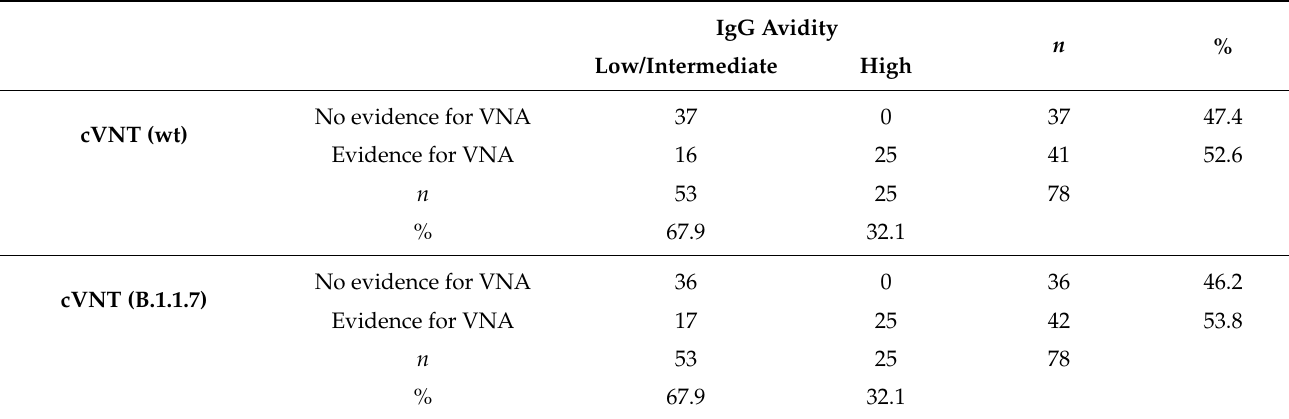
( a ) ( b ) Figure 6. Comparison of the results of the surrogate neutralization tests (sVNT) #1 ( a ) and #2 ( b ) with those of the cell-based neutralization test (cVNT) using a ‘wildtype’ SARS-CoV-2 strain (wt) and a B.1.1.7 strain as antigens. A serum dilution of >1:10 is considered as protective. The decision limits for relevant inhibition of SARS-CoV-2 receptor-binding domain interaction with the human angiotensin-converting enzyme 2 varies between ≥20% (sVNT#2) and ≥30% (sVNT#1). Spearman correlation coefficients were calculated with 0.85 (sVNT#1 vs. cVNT with wt), 0.80 (sVNT#1 vs. cVNT with B.1.1.7), 0.92 (sVNT#2 vs. cVNT with wt), and 0.85 (sVNT#2 vs. cVNT with B.1.1.7), re- spectively. Table 4. Qualitative agreement of results obtained in the cell-based virus neutralization test and of IgG avidities measured in the recom Line assay.